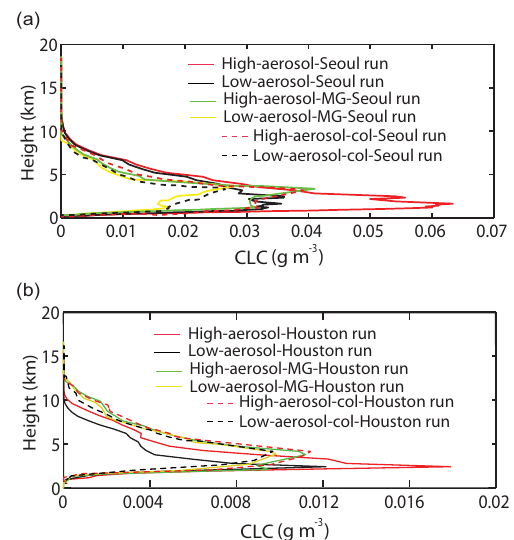
Figure 15. Vertical distributions of the time- and domain-averaged cloud liquid content (CLC) for (a) the Seoul case and (b) the Hous- ton case. Solid red and black lines represent simulations with the bin scheme and at the 500m resolution, while dashed red and black lines represent the bin-scheme simulations with the saturation ad- justment and the MG-scheme sedimentation and collection pro- cesses. Solid yellow and green lines represent simulations with the MG